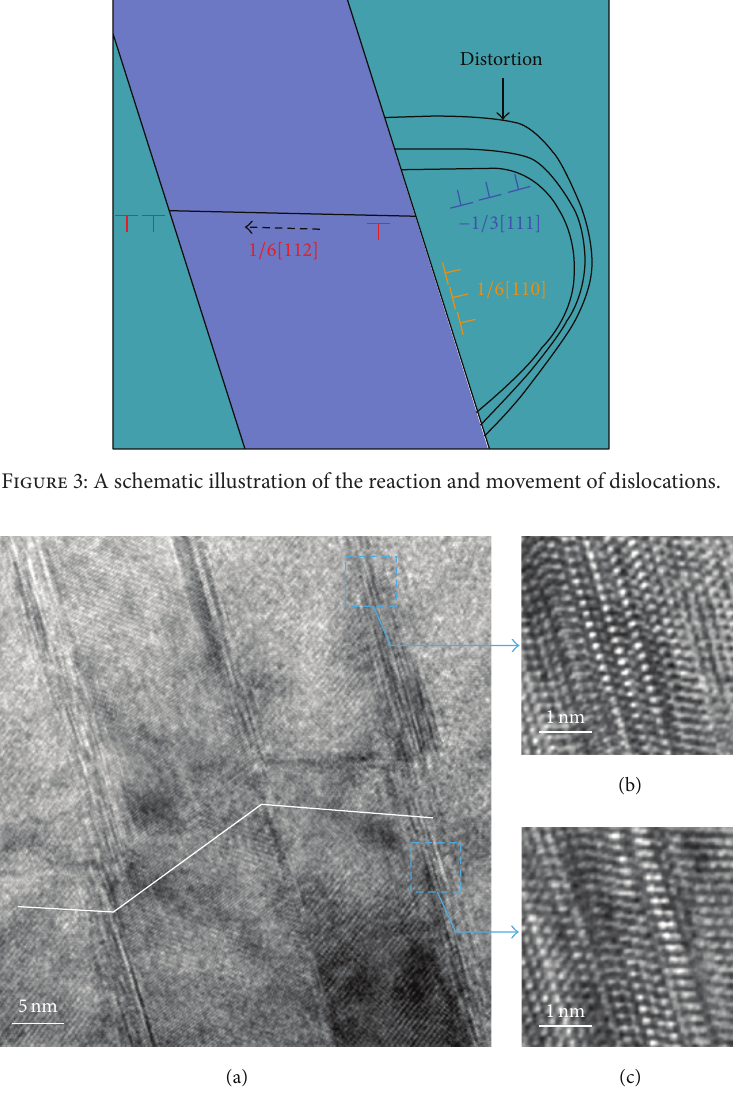
Figure 4: (a) A HRTEM graph of a ribbon of planar faults. (b) A magnified HRTEM graph of the upper 𝛾 / 𝛾 lath interface. (c) A magnified HRTEM graph of the lower 𝛾 / 𝛾 lath